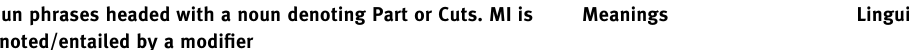
Table 5: The dish name denoting NP is headed by a noun denoting cuts or parts of the Source; the MI is entailed from or denoted by the modi fi ers of the head noun Noun phrases headed with a noun denoting Part or Cuts. MI is denoted/entailed by a modi fi er